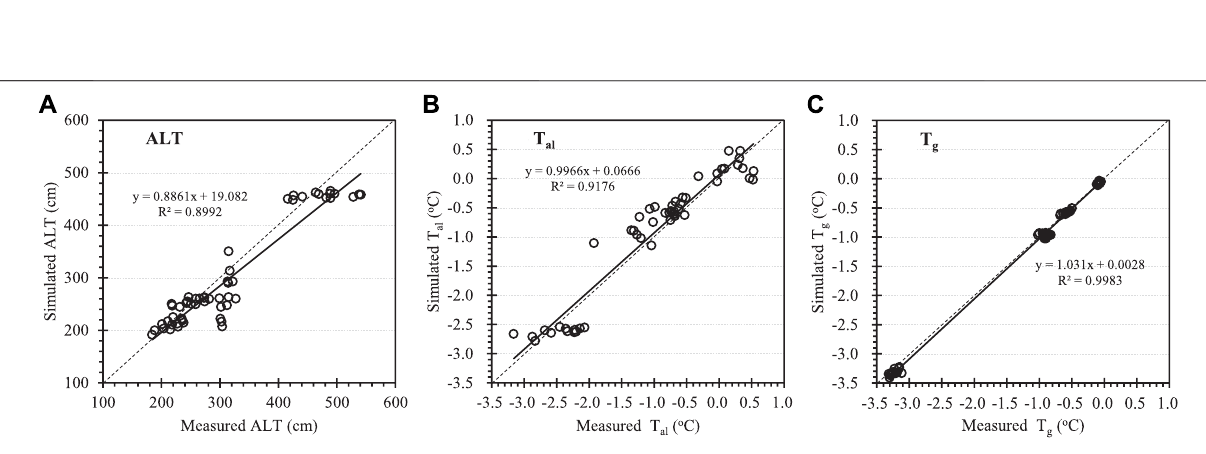
Frontiers in Environmental Science |